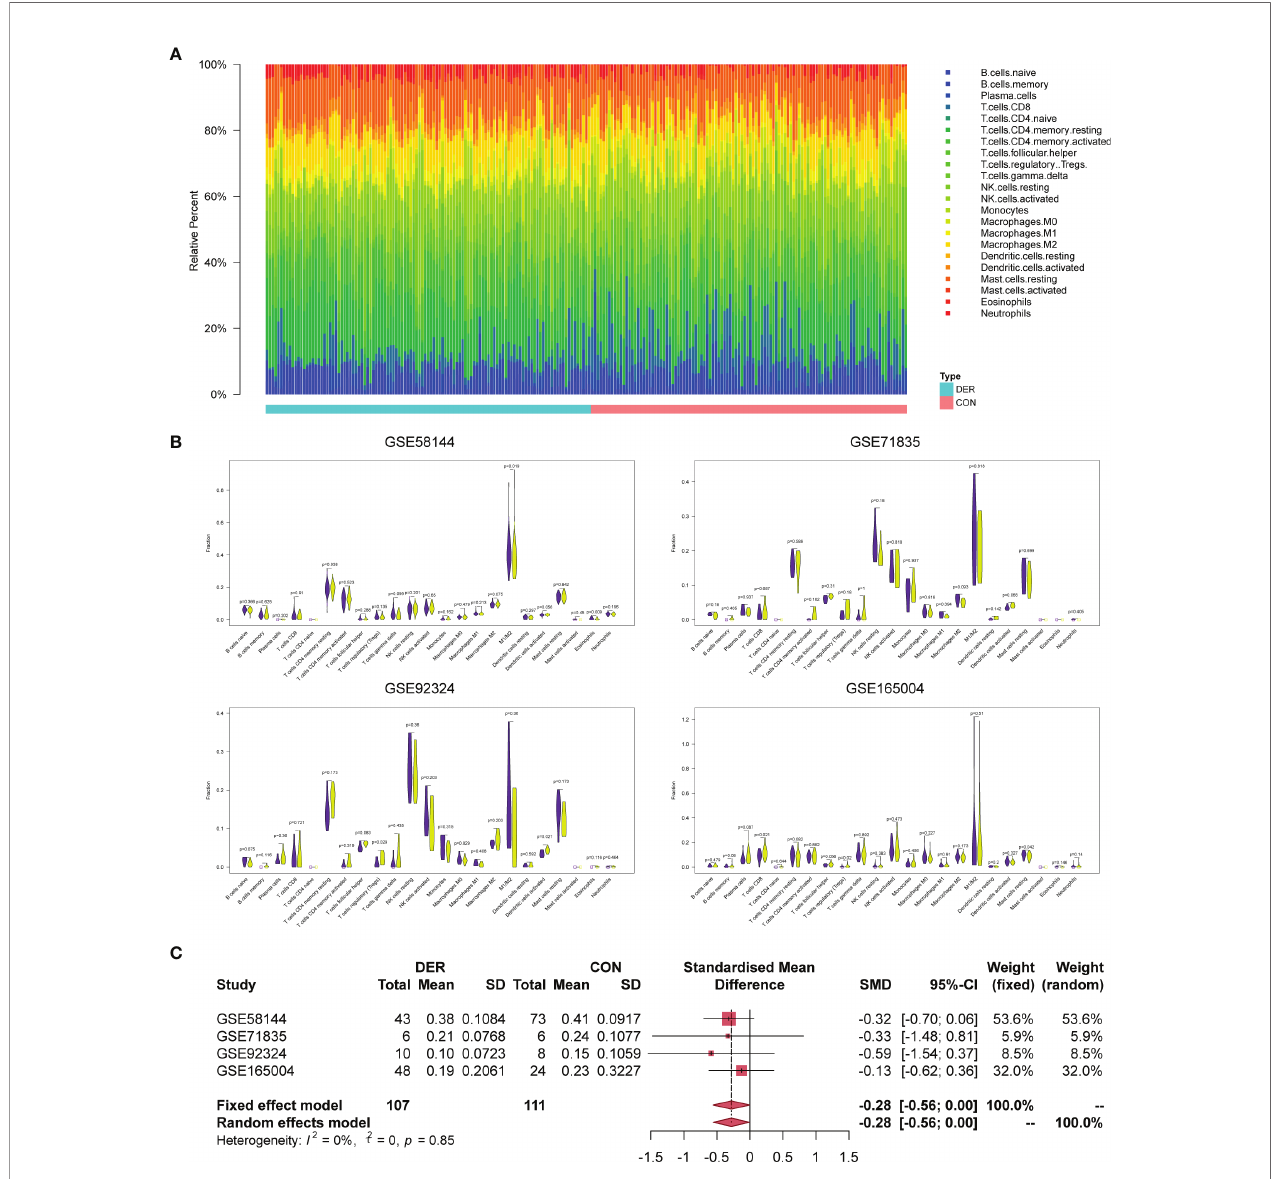
FIGURE 2 | Immune in fi ltration analysis and M f 1/M f 2 balance. (A) Bar plots of 22 immunocytes in endometrial mixed tissue samples, including four datasets with 218 subjects. (B) Violin plots for immune cells in the DER and control groups. Purple color represents the control group while yellow represents the DER group. (C) Meta-analysis of four datasets for M f 1/M f 2. DER, defective endometrial receptivity; CON,